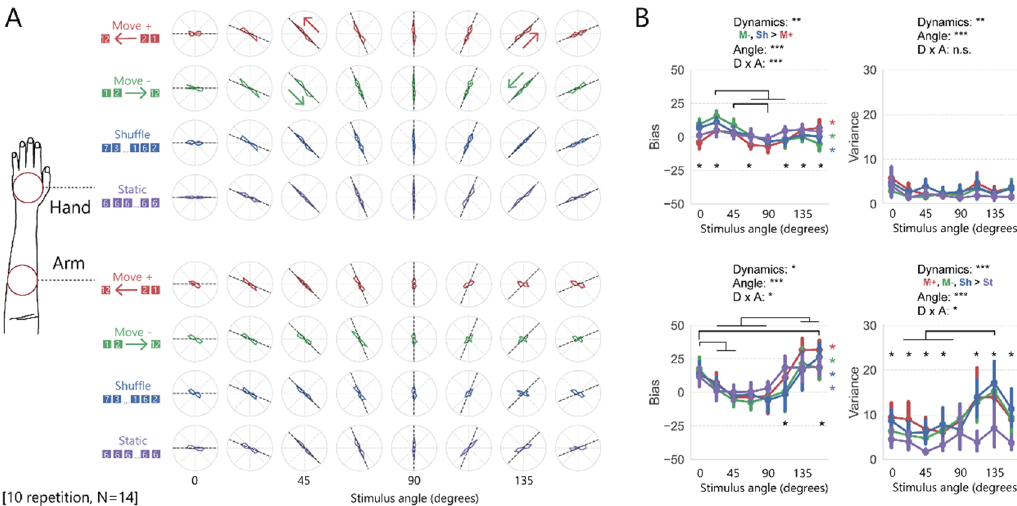
Figure 2. Results of Experiment 1. (A) The average rate of the stimulus orientation reported by the participants. Each column represents the results obtained with a stimulus presented at 0° to 157.5°. A stimulus at 0° was defined with respect to the front edge of the braille stimulator placed parallel to the table. Black dashed lines represent the angle of the presented stimuli, and each colored line represents the proportion of the reported angle under each condition. The red and green arrows indicate the direction in which the dot moved. (B) Bias and variance of reported orientation. In the bias graphs, positive values indicate a clockwise bias and negative values indicate a counterclockwise bias. The error bars represent 95% confidence intervals (CIs). See Table 1 for the results of the main analysis for all data for the hand and the arm. Notes, lines, and asterisks added to the data in each panel all represent the results of the post-hoc analysis for one of the body part sites: hand or arm. Black lines above the data are significance bars of multiple comparisons where the factor of the stimulus angle at the arm (or at the hand) was analyzed as a dependent mean. Asterisks on the graph represent simple effects for interaction between stimulus dynamics and stimulus angle: horizontally-aligned black asterisks represent significant simple effects of stimulus dynamics at each stimulus angle, while vertically-aligned coloured ones represent those of the stimulus angle for each stimulus dynamics, each with alpha level 0.05.